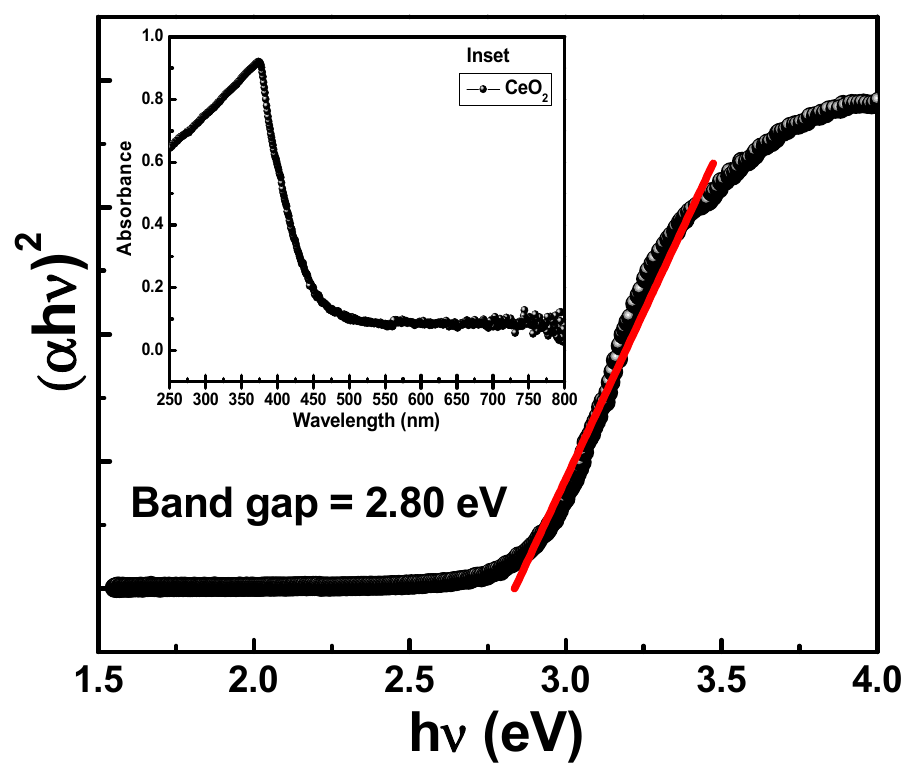
Figure 4. Tauc’s plot for the absorption of CeO 2 NPs. Inset shows the UV-Vis spectrum of CeO 2 nanoparticles.